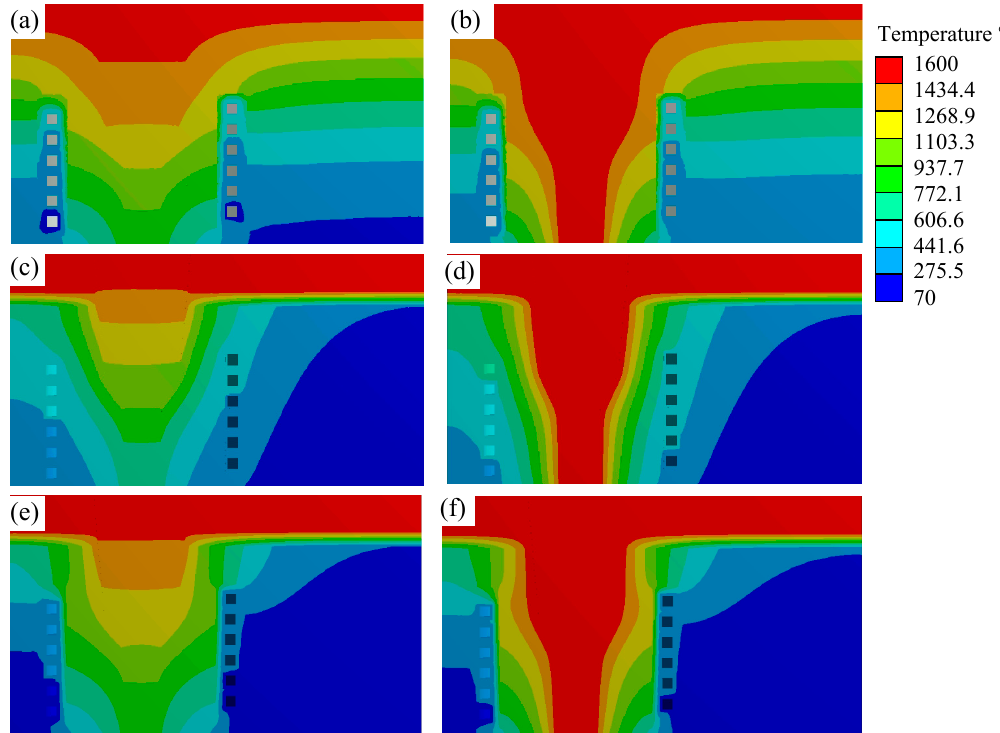
Figure 6. Temperature distribution of nozzle brick: method I ( a ) t = 330 min; ( b ) t = 370 min; method II; ( c ) t = 330 min; ( d ) t = 370 min; method III; ( e ) t = 330 min; ( f ) t = 370 min.